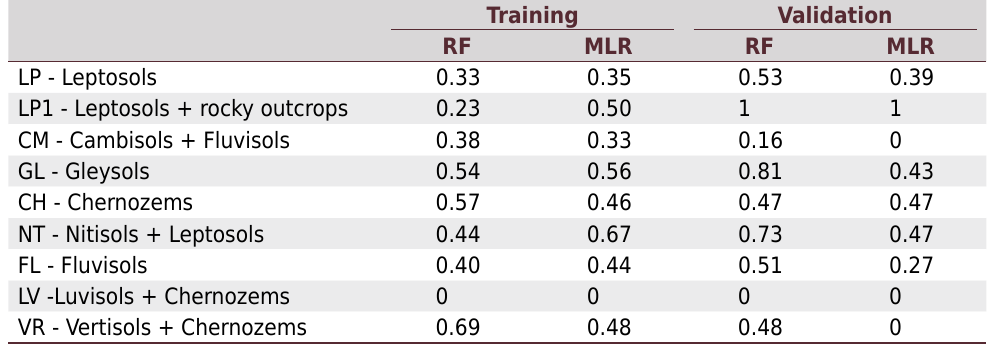
Table 6. Conditional Kappa of soil mapping by Random Forest (RF) and Multinomial Logistic Regression (MLR) for training and validation